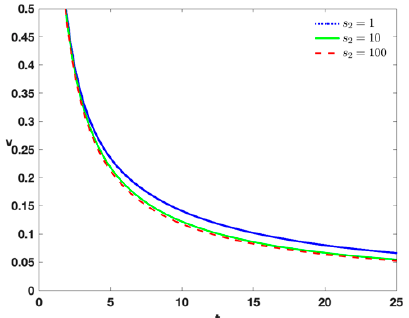
Figure 6. Time series of tumor cells with a = 0.9, m 2 = 1, s 1 = 3 and different treatment by higher different densities of s 2 .